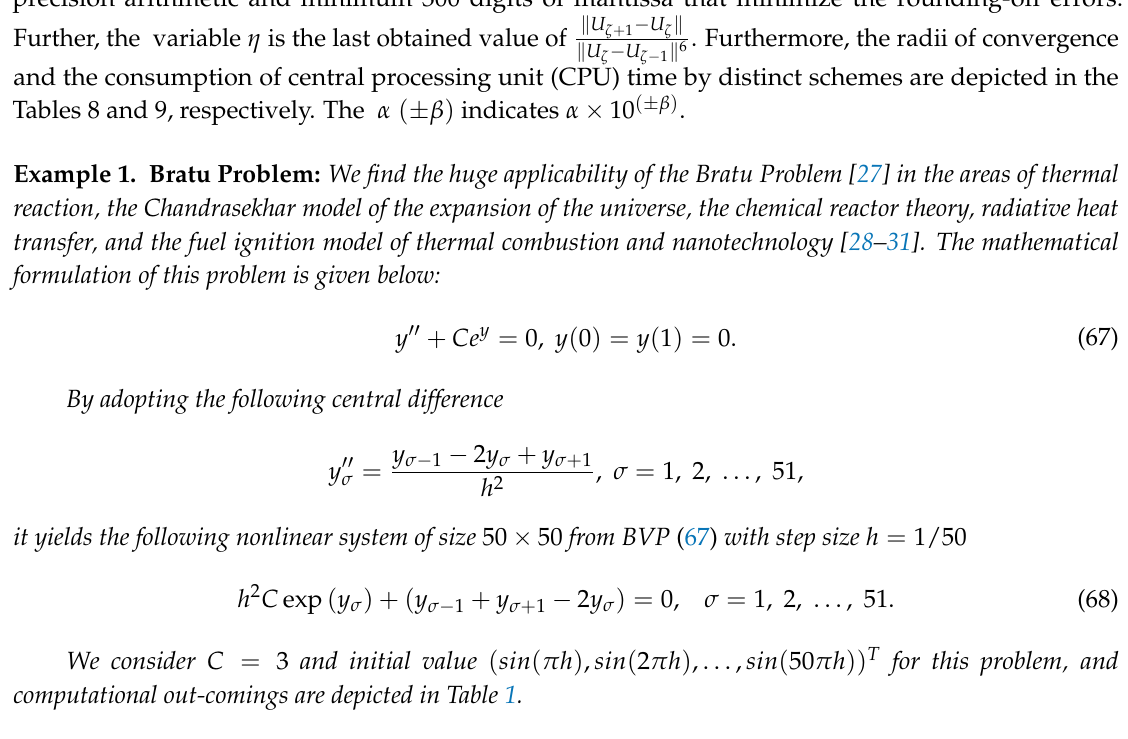
Table 1. Conduct of different techniques in Bratu’s problem Example